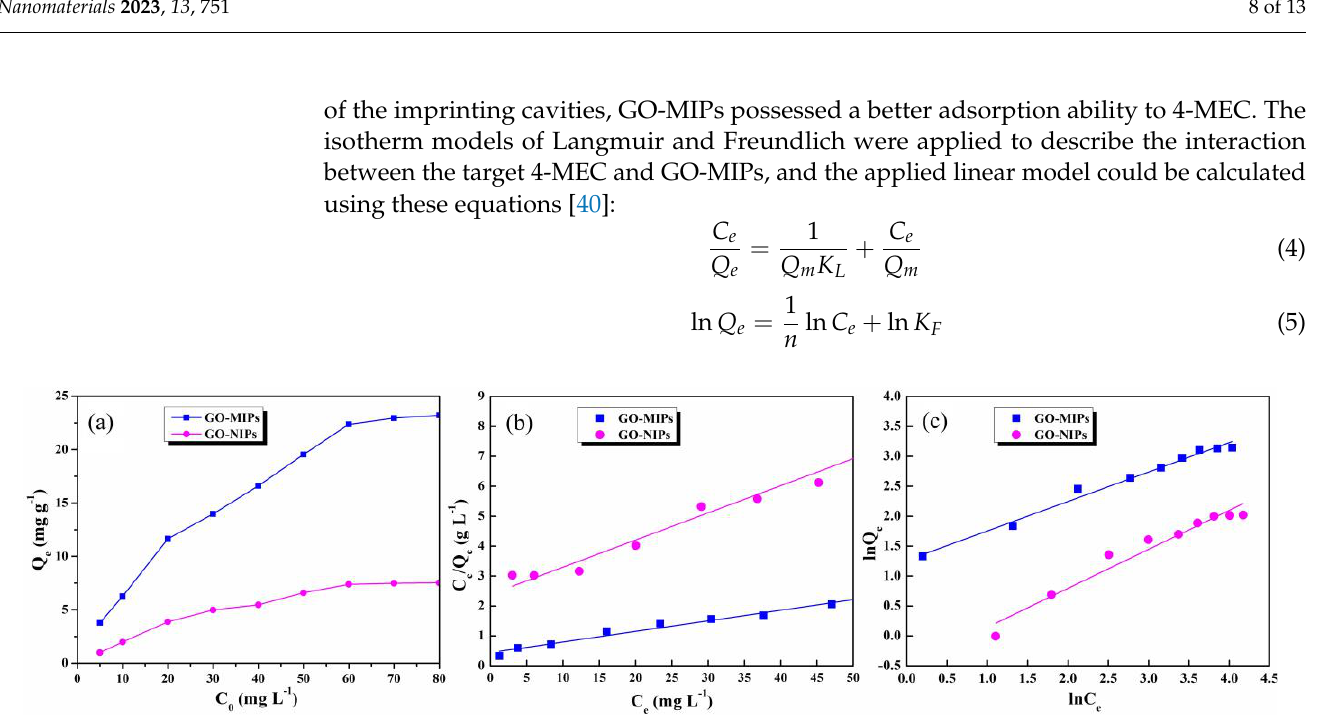
Figure 5. Adsorption isotherms ( a ), Langmuir ( b ), and Freundlich ( c ) isotherm models of GO-MIPs and GO-NIPs.